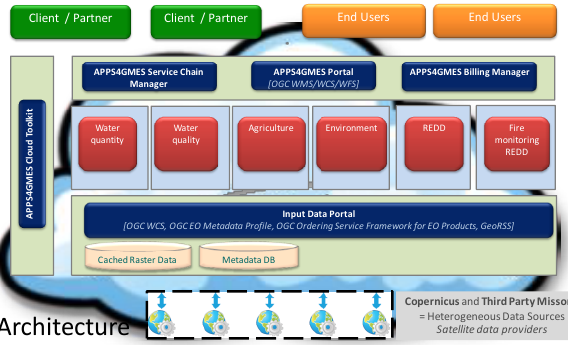
Figure 1. APPS4GMES architecture, showing the embedding of the services (red) with the shared project modules (blue) within the cloud architecture (Appel